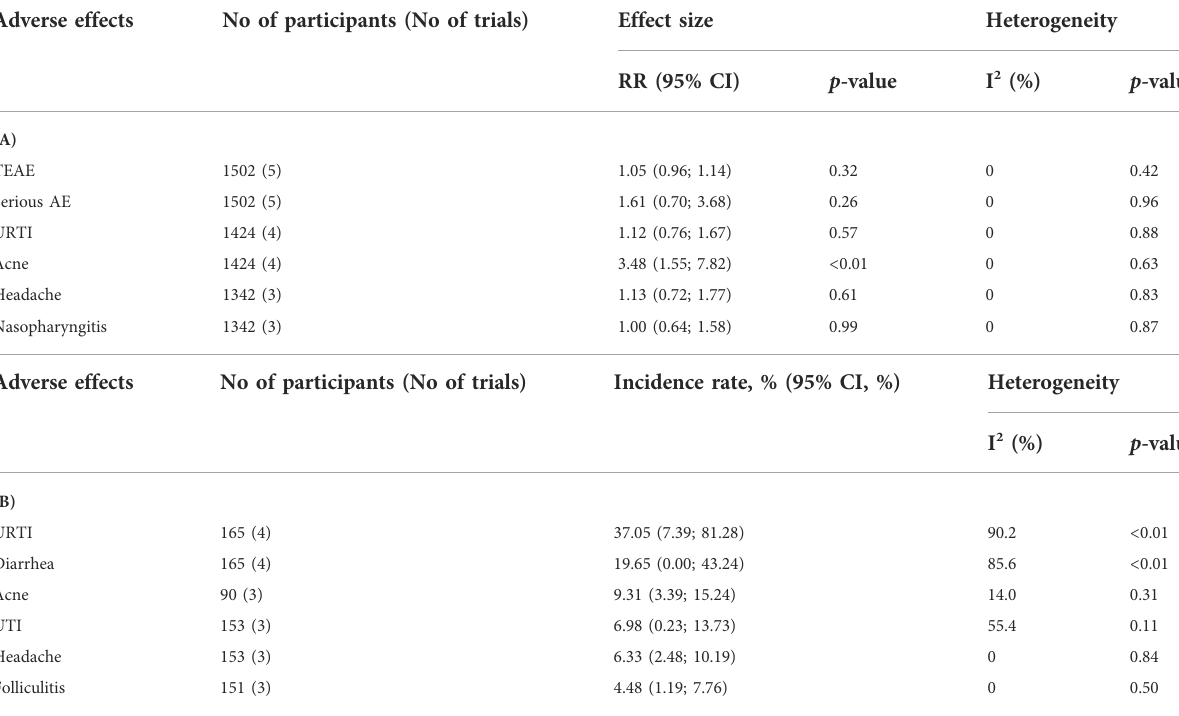
TABLE 4 Adverse events and incidence rate in (A) RCTs and (B)